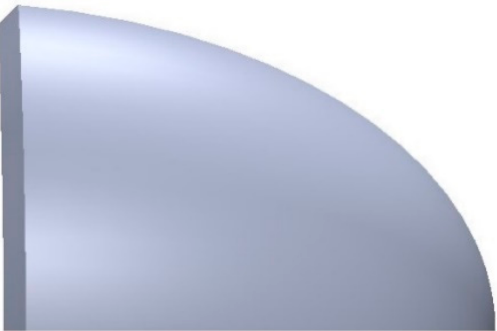
Figure 8. Test points and regions of the high beam. The traditional design uses an ellipsoidal reflector to focus the rays emitted from the source, while part of the rays emitted from the high beam source will be blocked by the low beam source due to the volume of the LED source. It will cause significant energy losses, as shown in Figure 9a. Therefore, the construction in Figure 1 is adopted to improve light efficiency and illumination. Rays emitted from the high beam source focus on a point on Z axis by the freeform surface reflector, as shown in Figure 9b.